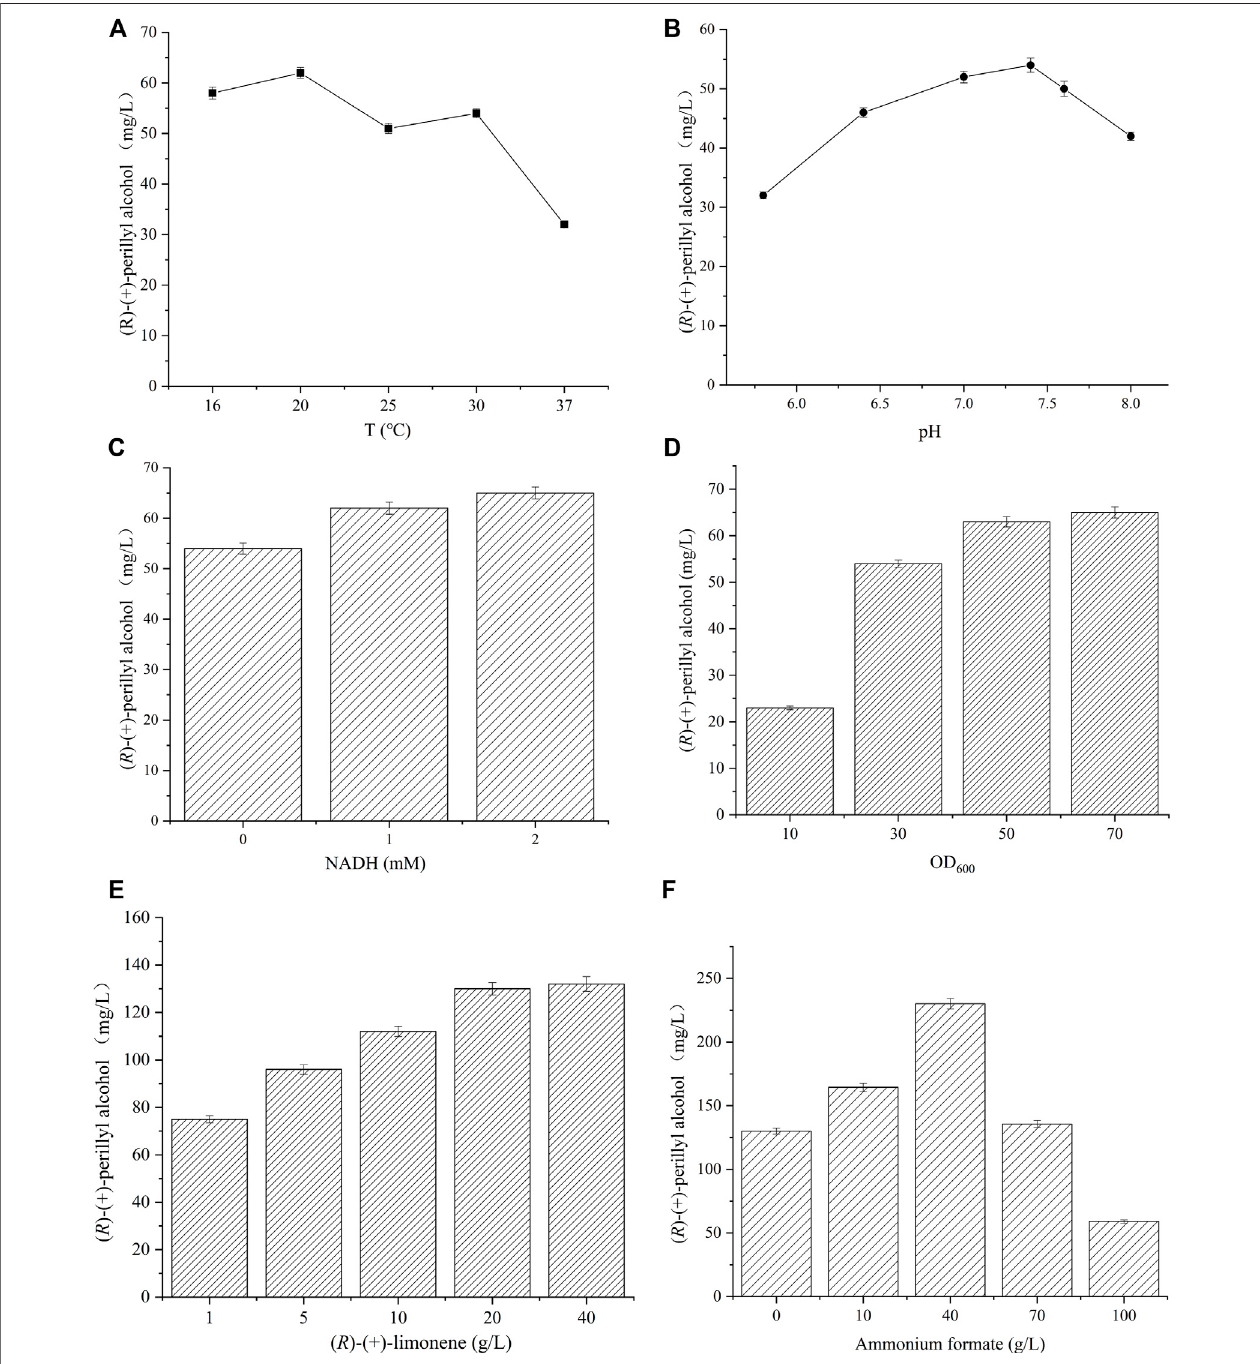
FIGURE 4 | Reaction condition optimization for ( R )-(+)-perillyl alcohol synthesis. The effect of (A) varying pHs and (B) temperatures on ( R )-(+)-perillyl alcohol synthesis.Reactionconditions(20 ml)fordifferentpHs:wholecellcatalysts(OD 600 =30),25 μ l( R )-(+)-limonene,8.0 mldioctylphthalate(DINP),andPBSbuffer(50 mM, pH 5.8 – 8.0) at 30 ° C for 6 h. Reaction conditions (20 ml) for different temperatures: whole cell catalysts (OD 600 = 30), 25 μ l ( R )-(+)-limonene, 8.0 ml dioctyl phthalate (DINP), and PBS buffer (50 mM, pH 7.4) at 16 – 37 ° C for 6 h. (C) Effects of NADH addition on ( R )-(+)-perillyl alcohol production. Reaction conditions (20 ml): whole cell catalysts (OD 600 = 30), 25 μ l ( R )-(+)-limonene, 8.0 ml dioctyl phthalate (DINP), NADH (0 – 2 mM), and PBS buffer (50 mM, pH 7.4) at 30 ° C for 6 h. (D) Effect of biocatalystsconcentrationson( R )-(+)-perillylalcoholproduction.Reactionconditions(20 ml):wholecellcatalysts(OD 600 =10,30,50,70),25 μ l( R )-(+)-limonene,8.0 ml dioctylphthalate(DINP),andPBSbuffer(50 mM,pH7.4)at30 ° Cfor6 h. (E) Wholecellbiotransformationof( R )-(+)-perillylalcoholathigh( R )-(+)-limoneneconcentration. Reaction conditions (20 ml): whole cell catalysts (OD 600 = 50), ( R )-(+)-limonene (1, 5, 10, 20, 40 g/L), 8.0 ml dioctyl phthalate (DINP), 2 mM NADH, and PBS buffer (50 mM, pH 7.4) at 30 ° C for 6 h. (F) ( R )-(+)-perillyl alcohol production with different ammonium formate concentrations. Reaction conditions (20 ml): whole-cell catalysts (OD 600 = 50), 500 μ l( R )-(+)-limonene, 8.0 mldioctyl phthalate (DINP), ammonium formate (0, 10, 40,70, 100 g/L), and PBSbuffer (50 mM, pH 7.4) at 30 ° Cfor 6 h. Data expressed as mean ± s.d. ( n = 3).